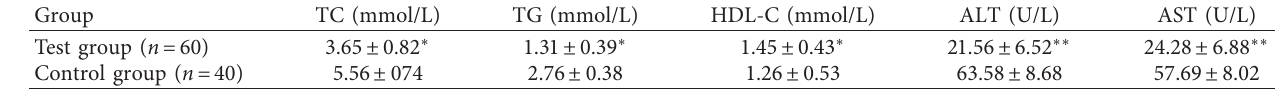
Table 1: The serum levels of TC, TG, HDL-C, ALT, and AST between the test and control groups. Group